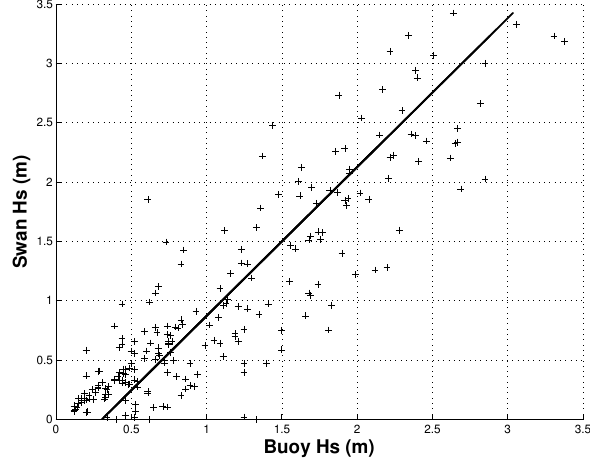
Fig. 13. Bathymetry and position of the buoy near Tropea.